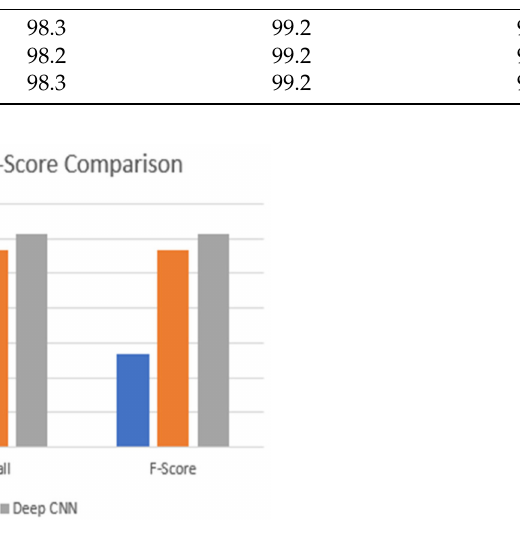
Figure 12. Precision, Recall, and F 1 -Score Comparison of CNN, LeNet, and the Proposed DCNN on the Pashto Characters